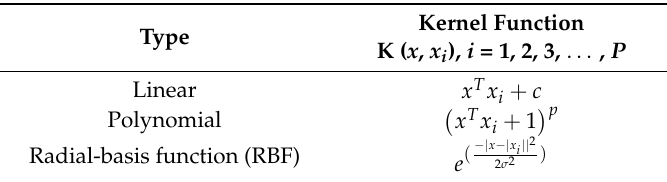
Table 1. Inner product kernel